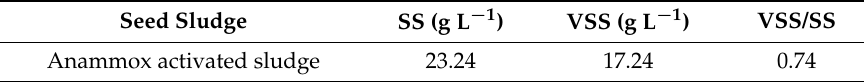
Table 1. Characteristics of seed sludge.